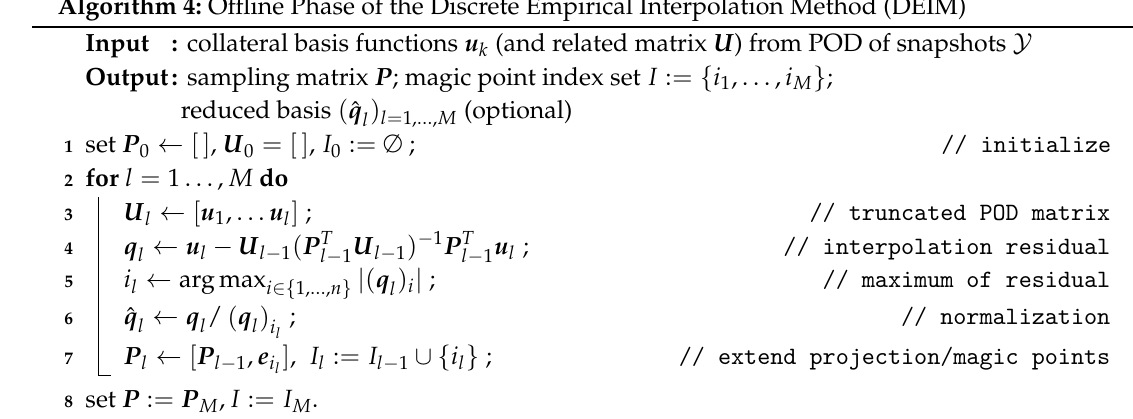
Algorithm 4: Offline Phase of the Discrete Empirical Interpolation Method